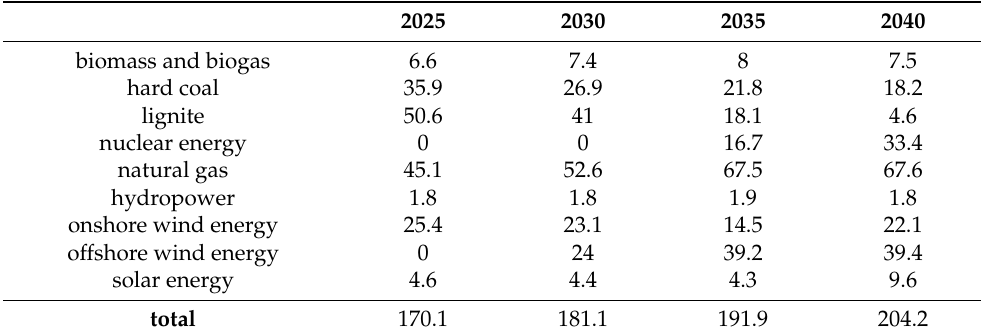
Table 1. Net electricity production forecast